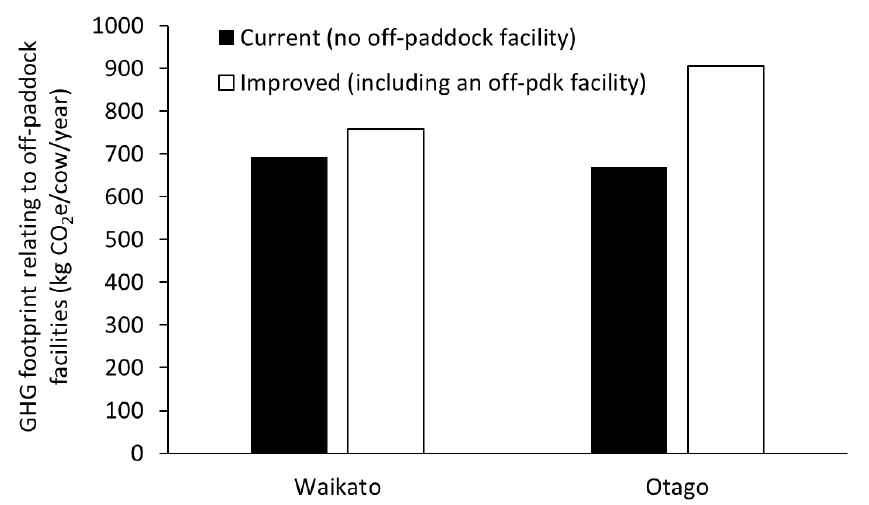
Figure 2. Effect of off-paddock facilities on net greenhouse gas emissions (kg CO 2 e/cow/year) associated with N 2 O from excreta deposition onto paddocks, and N 2 O and CH 4 emissions from manure management.